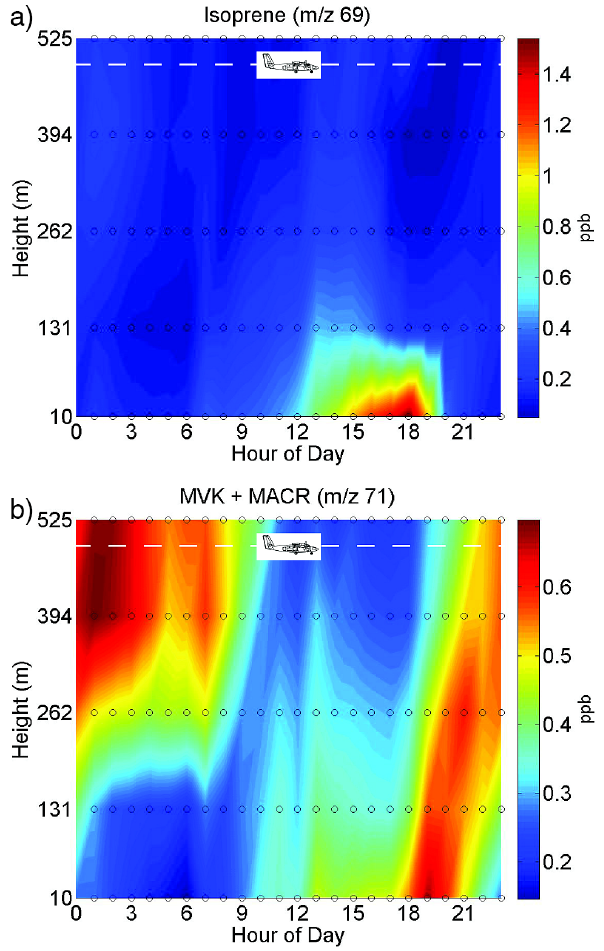
Figure 7. Comparison of airborne BEFs with MEGAN’s land cover 2.2 for isoprene (airborne BEFs are subject to additional uncertain- ties introduced from T , and PAR and the algorithm’s activity factor used in normalization). (a) full extent with a rectangle denoting (b) zoomed area. The white dots represent rejected flux data due to flux quality control, aircraft turns, or